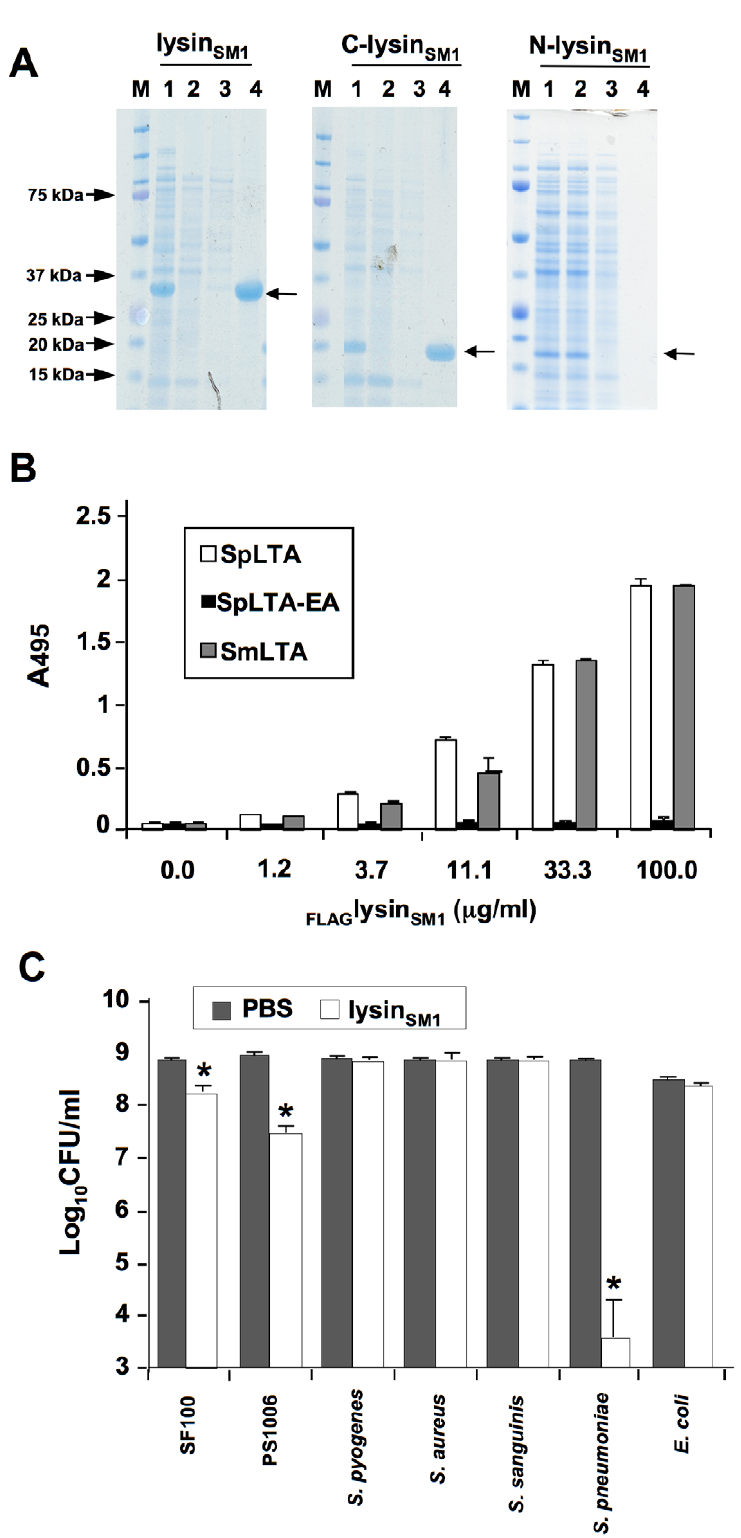
Figure 2. Lysin binding to phosphocholine (PC) residue and its biological activity. (A) Binding of lysin SM1 and its truncated forms to DEAE- cellulose. Samples were separated by SDS-PAGE and stained with Coomassie blue. M: MW standards; lane 1: whole cell extracts of E. coli expressing indicated protein ; lane 2: proteins not retained by DEAE cellulose column; lane 3: proteins eluted with 1.5 M NaCl - 0.1% choline chloride; lane 4: proteins eluted with 2% choline chloride. Arrows indicate position of expressed proteins. (B) Binding of FLAG lysin SM1 to immobilized LTA from Streptococcus pneumoniae (SpLTA), PC-negative pneumococci (SpLTA-EA), or Streptococcus mitis (SmLTA). Bars indicate the means ( 6 S.D.) of triplicate results in a representative experiment. (C) Bactericidal activity of lysin SM1 . Values shown are number of surviving bacteria after exposure to lysin SM1 or buffer (mean 6 S.D.). * = P , 0.05, compared with the same strain exposed to buffer alone. doi:10.1371/journal.ppat.1001047.g002 PLoS Pathogens | www.plospathogens.org 3 August 2010 | Volume 6 | Issue 8 |